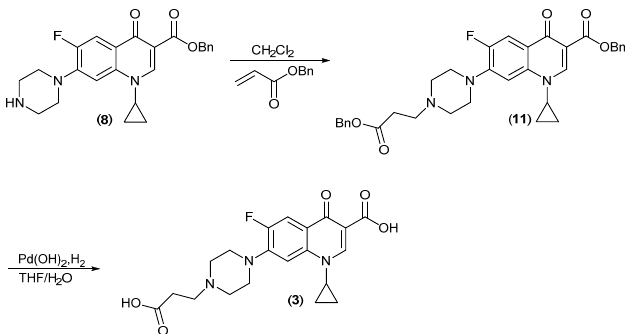
Scheme 2. Synthesis of the Ciprofloxacin control derivative ( 3 ) from Ciprofloxacin Benzyl ester ( 8 ).